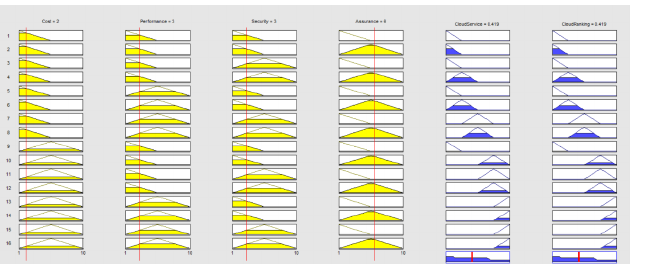
Figure 4. Rule Viewer of Proposed AFIS